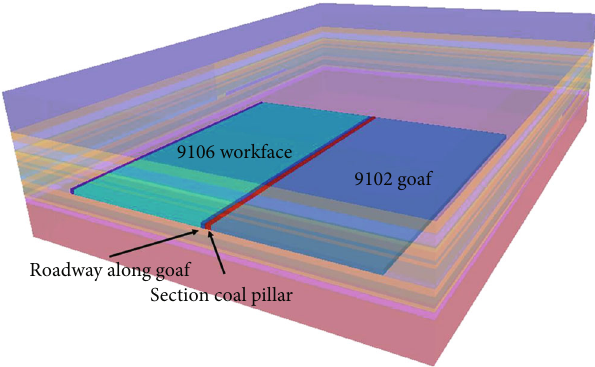
Figure 2: Numerical calculation model of 9106 Table 1: Physical and mechanical parameters of roof and fl oor of 9106 workface.